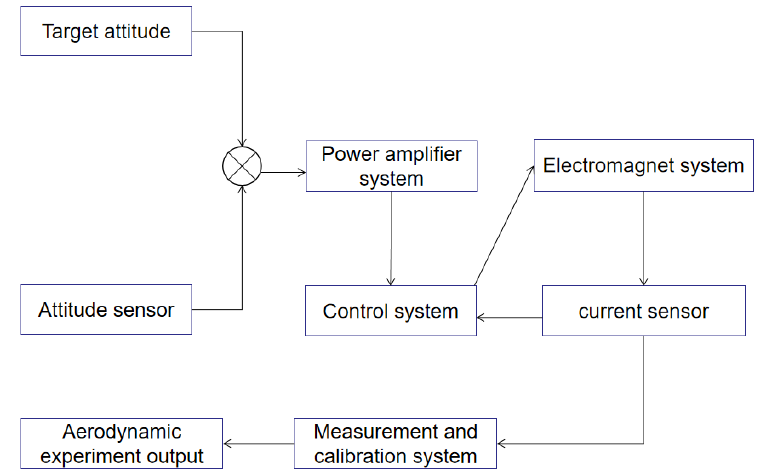
Figure 1. Structure diagram of magnetic suspension wind tunnel